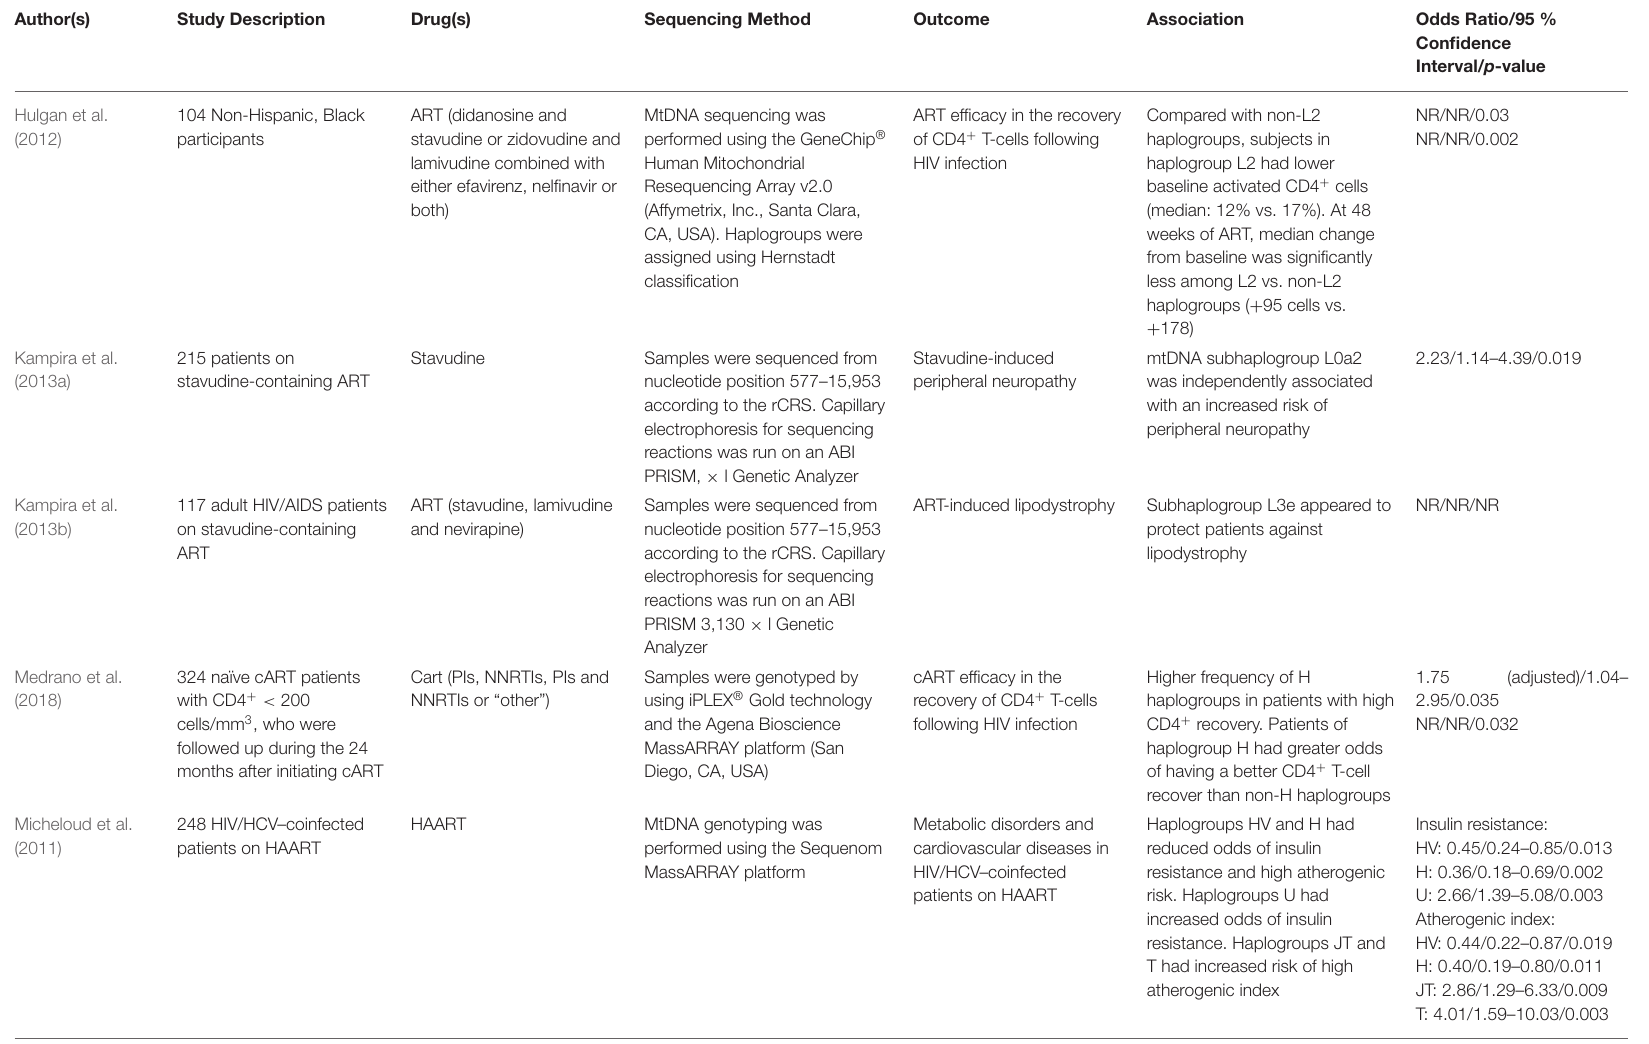
Abstraction table details the author(s), study design, drug(s) of interest, sequencing methods, outcomes, associations and statistics. ACTG, AIDS Clinical Trials Group; (c)ART, (combined) antiretroviral therapy; DEXA, dual-energy X-ray absorptiometry; HAART, highly active antiretroviral therapy; HCV, hepatitis C virus; HIV, human immunodeficiency virus; MHCFV, mitochondrial haplogrouping using candidate functional variants approach; mtDNA, mitochondrial DNA; NR, not reported; (N)NRTIs, (non)-nucleotide/nucleoside reverse transcription inhibitors; PI, protease inhibitors; rCRS, revised Cambridge reference sequence; SNP, single nucleotide